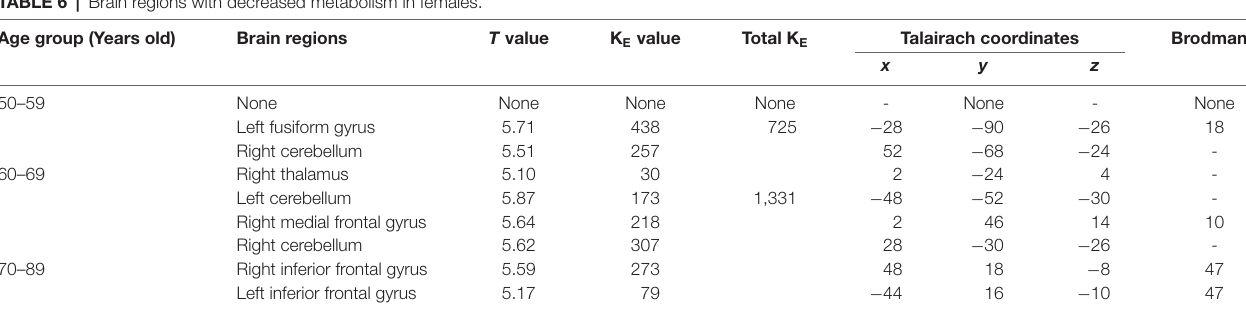
TABLE 6 | Brain regions with decreased metabolism in females.